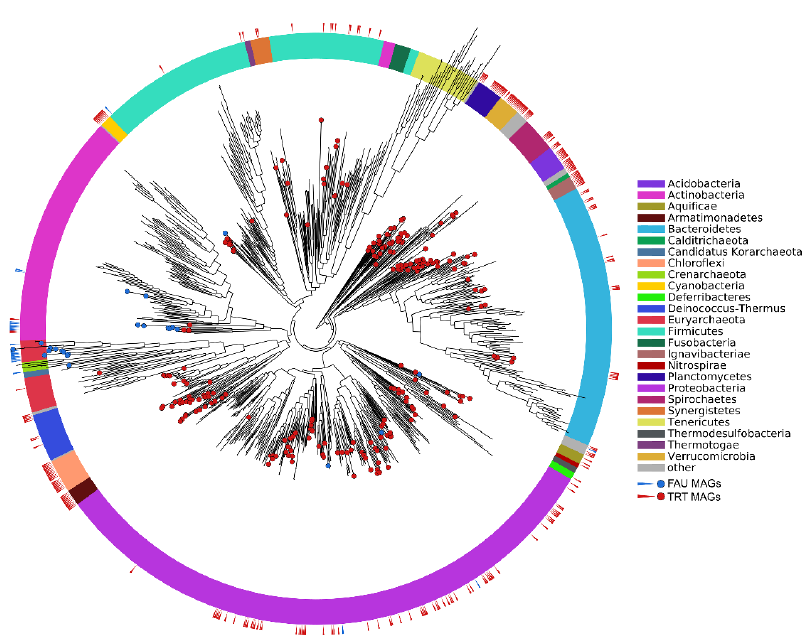
Figure 2. Phylogenetic position of the obtained MAGs on the prokaryotic tree of life. Colors of the ring sectors denote microbial phyla.